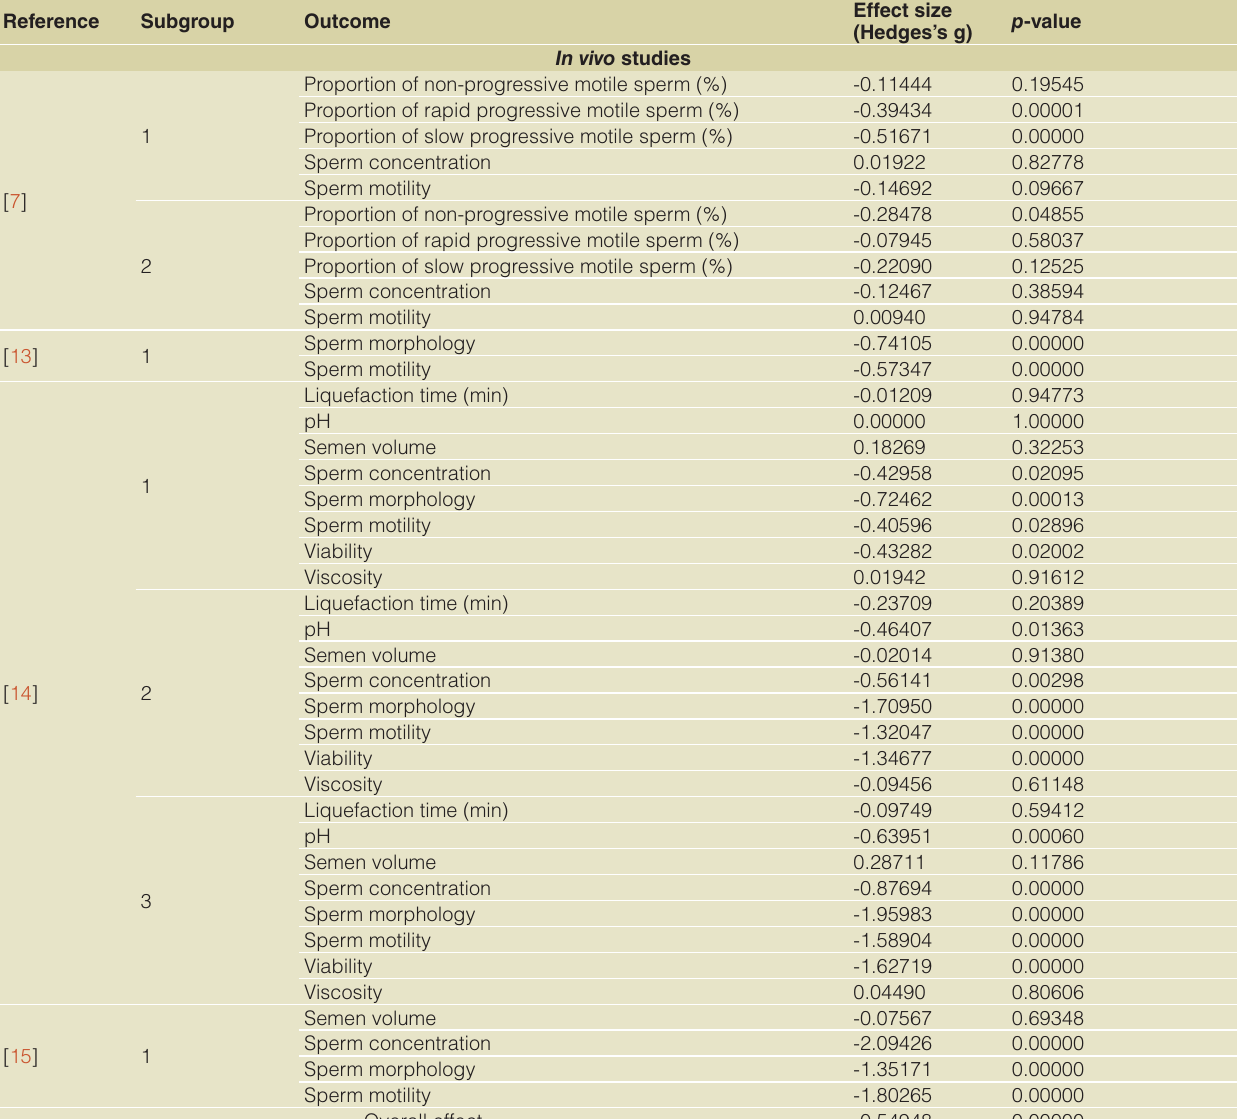
Supplementary Table 1. Effect sizes of sperm quality traits from the studies included in the